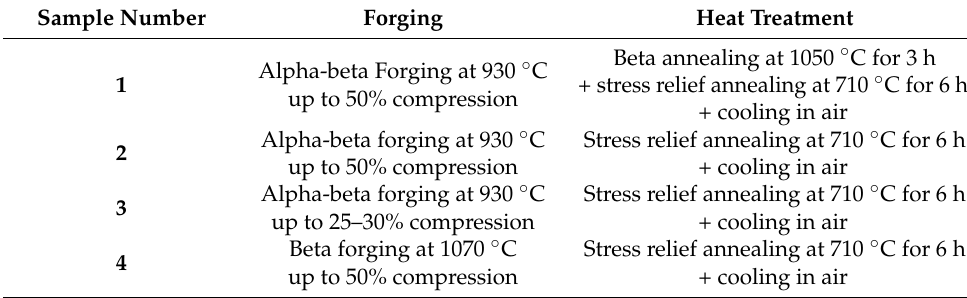
Table 3. Applied thermomechanical treatments after L-DED manufacturing.